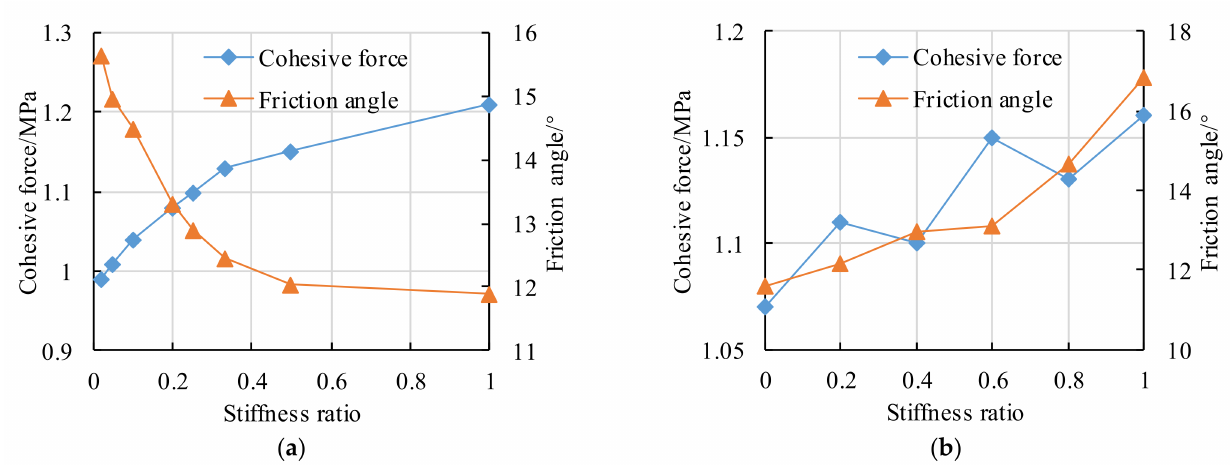
Figure 11. Mohr-Coulomb strength with properties of CRA: ( a ) stiffness ratio; ( b ) friction